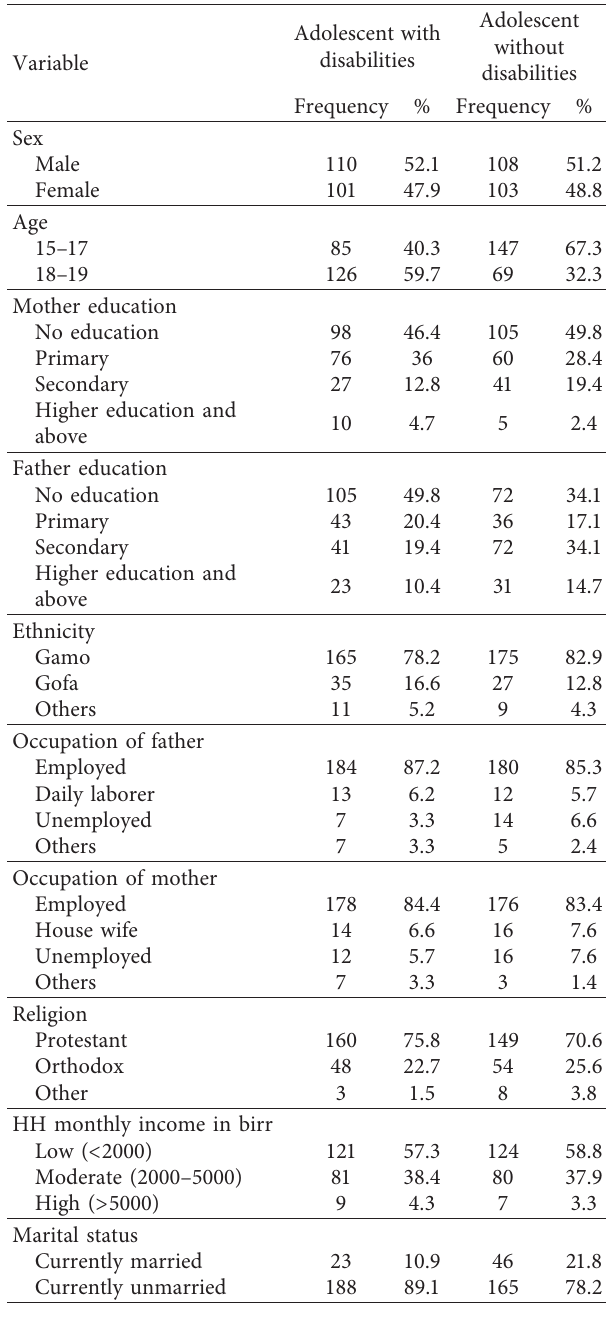
Table 1: Frequency distribution of adolescents by their background characteristics in Arba Minch town school,